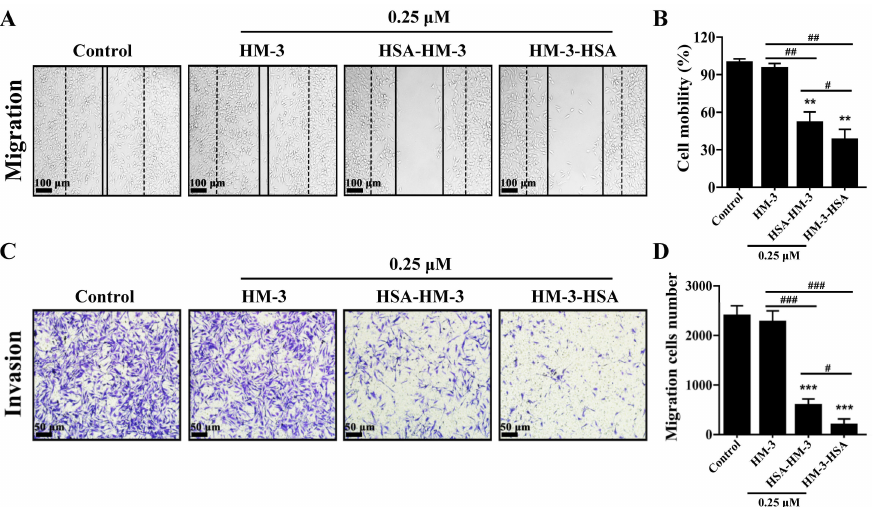
Figure 6. The effect of HM-3/HSA on B16F10 cells’ migration and invasion. ( A , B ) HM-3/HSA inhibited B16F10 cells’ migration. Cell migration of B16F10 cells was assessed by the wound-scratch assay. The dotted line indicates the baseline immediately at the wound scratch, whereas the solid line indicates the migration at 48 h after HM-3, HSA-HM-3, or HM-3-HSA treatment. Scale bar = 100 µ m. ( C , D ) HM-3/HSA inhibited B16F10 cells’ invasion. Cell invasion of B16F10 cells was assessed by the trans-well assay after HM-3, HSA-HM-3, or HM-3-HSA treatment for 48 h. Scale bar = 50 µ m. Control: cells treated with the PBS vehicle only. Data shown are means ± standard deviation from three independent experiments. ** p < 0.01 and *** p < 0.001 vs. control; # p < 0.05, ## p < 0.01, and ### p <